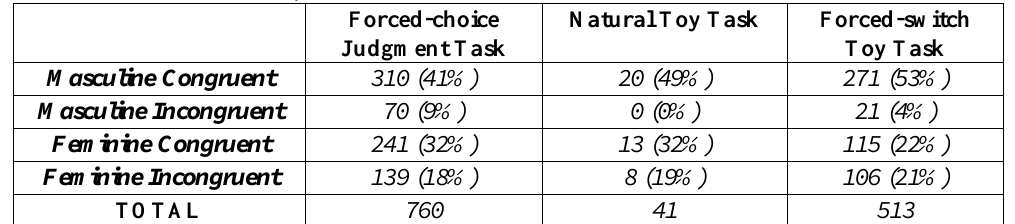
Table 3. Distribution of responses from the three